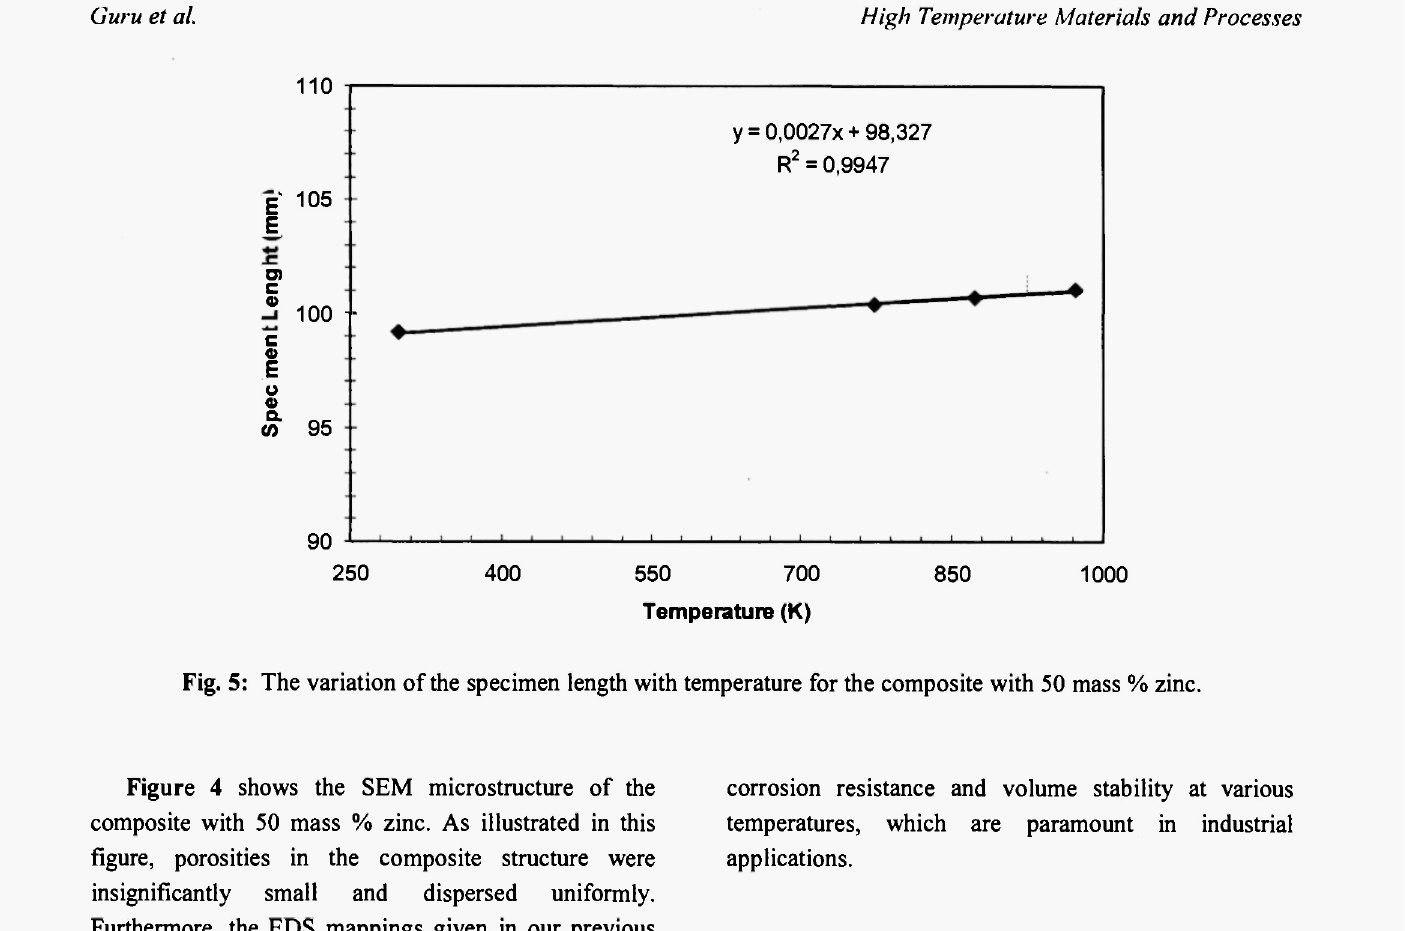
corrosion resistance and volume stability at various temperatures, which are paramount in dispersed